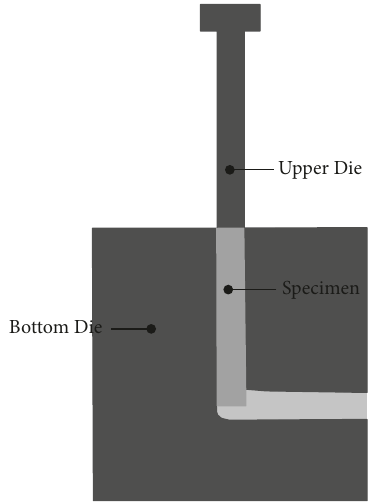
Figure 1: Structural diagram of ECAP